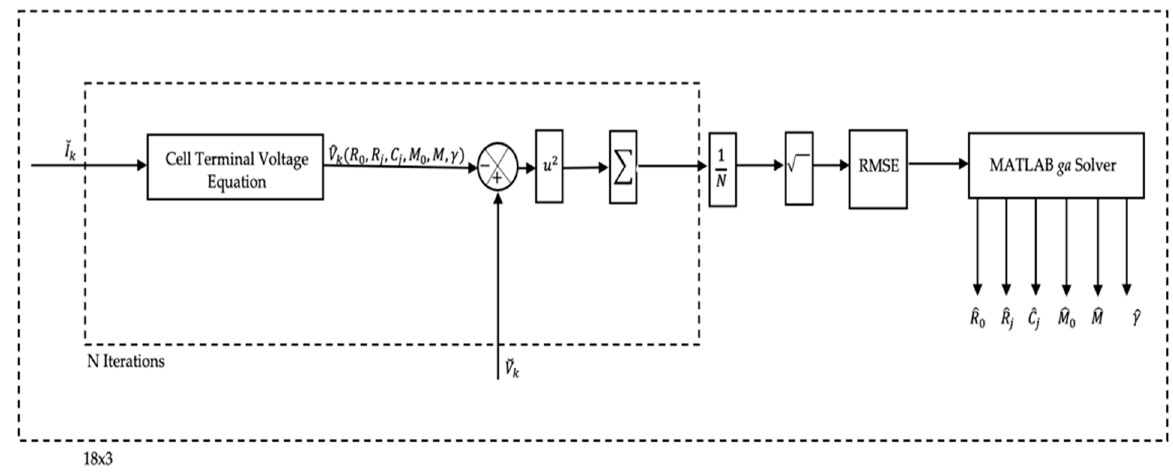
Figure 5. Parameter identification simulation procedure. Table 3. Experimental layout and data.